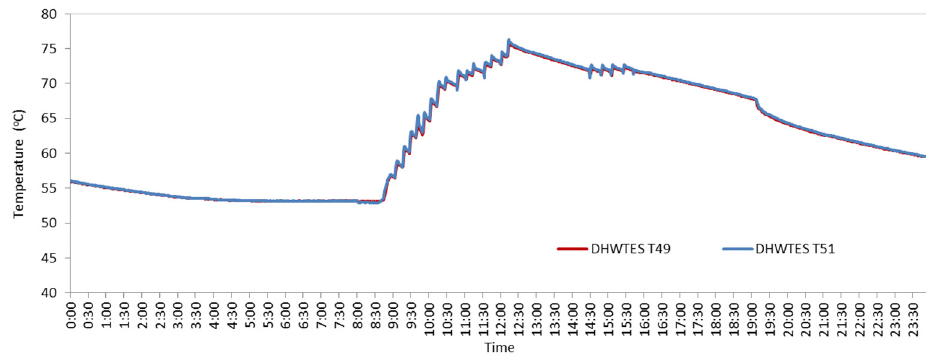
Figure 12. DHW TES tank temperature on 24 of August 2019.